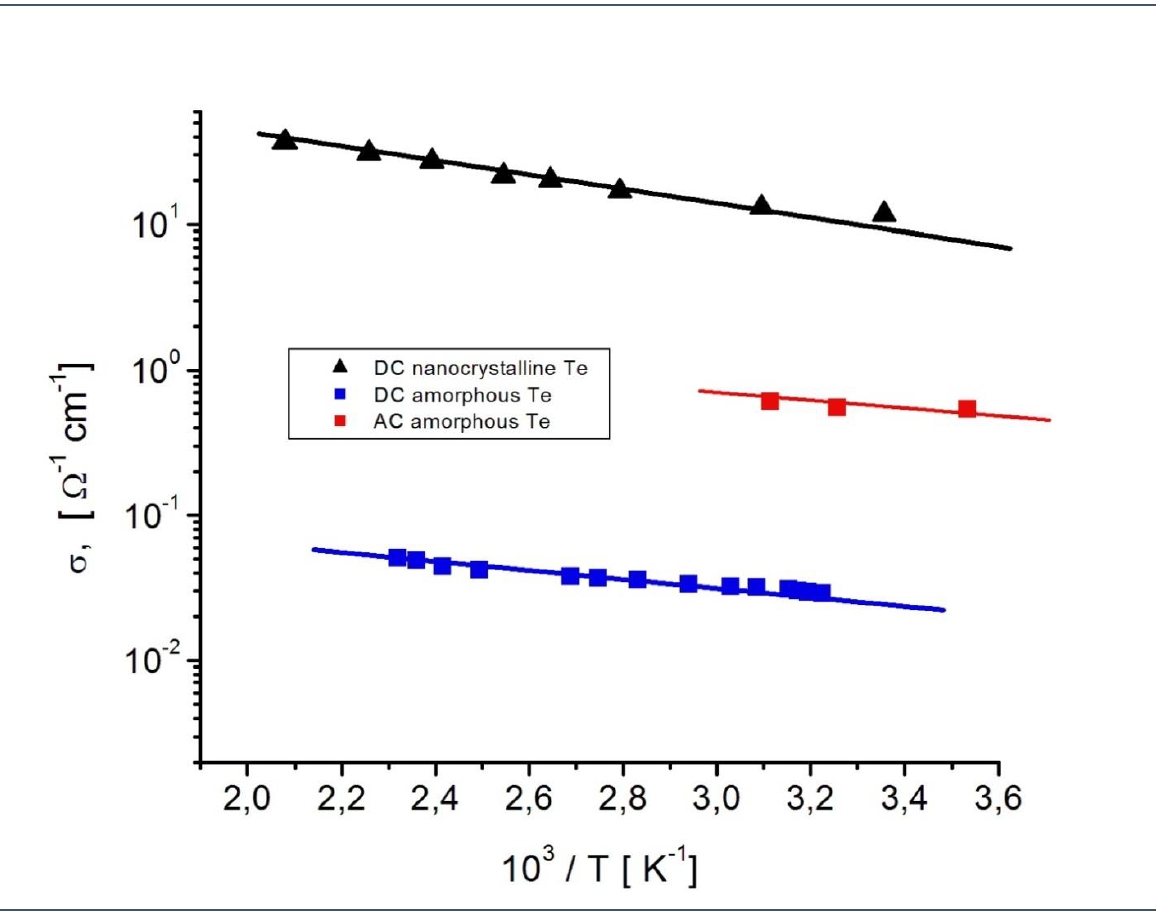
Figure 3. DC and AC conductivity of nanocrystalline and amorphous tellurium films versus reciprocal